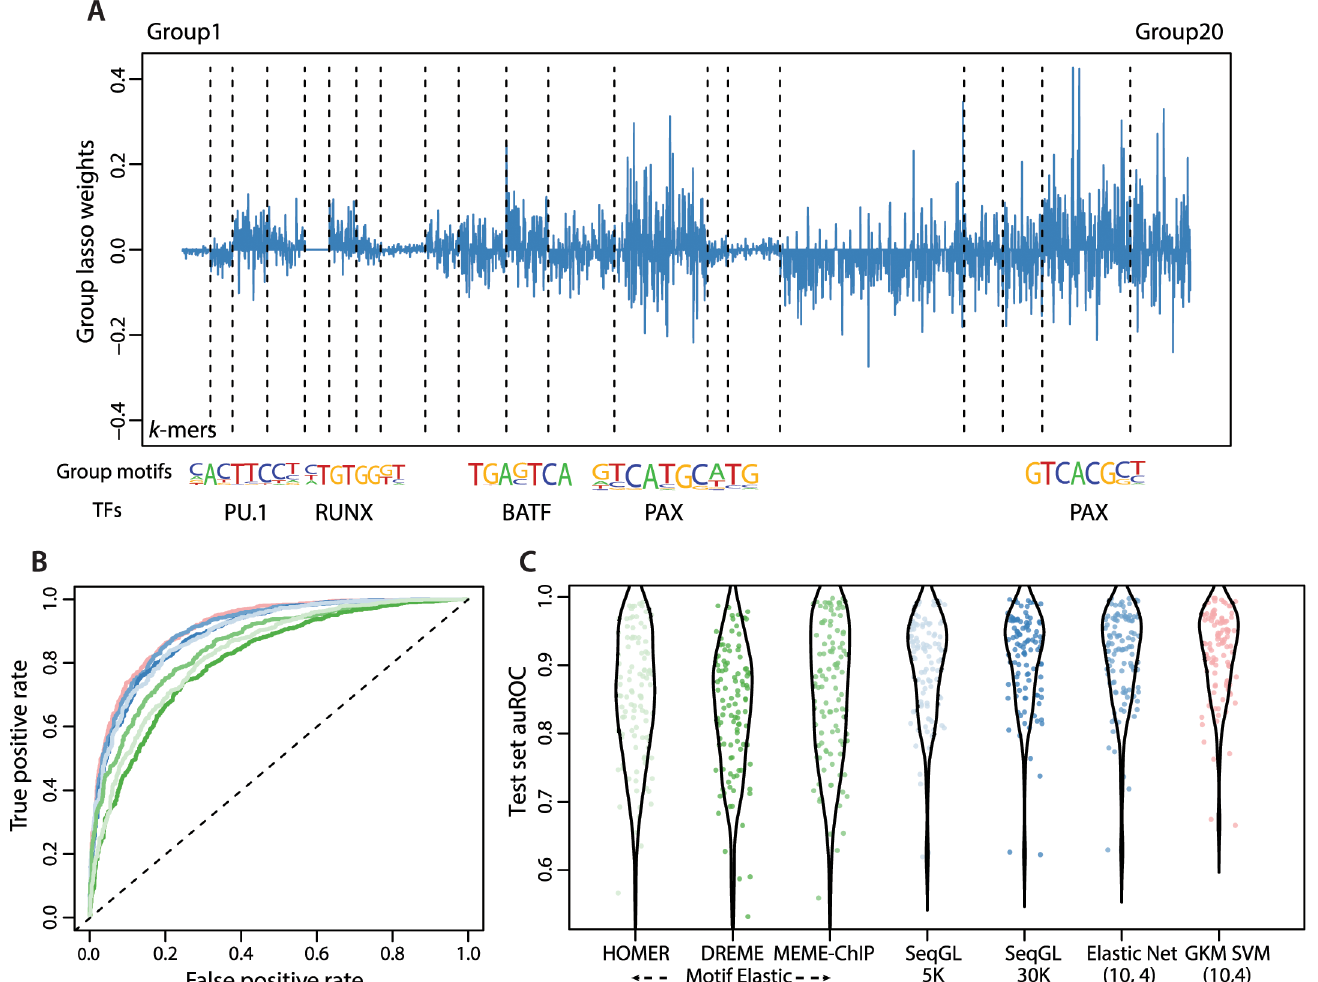
Fig 2. SeqGL performs significantly better than traditional motif discovery methods across different settings. (A) Plot showing the k -mer weight inferred group lasso regularized logistic regression for PAX5 ChIP-seq in GM12878 cell line. A number of groups are uniformly set to 0 (Group 5), while other groups are either significantly predictive of peaks or flanks (Group 3 and Group 2 respectively). Motifs identified for groups that are strongly predictive of peaks and the corresponding TFs are also shown. (B) PAX5 ChIP-seq auROC on the test set comparing the discriminative performance of SeqGL with motif finding tools and k -mer methods. The different colors correspond to the colors in Fig 2C. (C) Plots showing auROCs on test sets for 105 ChIP-seq experiments using different tools and settings. Three different settings were used for the motif finding tools HOMER, DREME and HOMER (see S1 Fig). ‘ Best motif ’ uses the highest-ranking motif from each method, as defined by the p -value; ‘ Max motif ’ uses the motif with maximum log odds score in each example; and ‘ Motif elastic ’ uses elastic net logistic regression across all motifs determined by the respective method. Only the ‘ Motif elastic ’ methods are shown in the performance plots, since they outperform the ‘ Best motif ” and ‘ Max motif ” methods. ‘ SeqGL and other k -mer methods significantly outperform the different motif finding tools across all settings (Wilcoxon rank sum p -values < 7e-3). gkm-SVM performs marginally (but not significantly) better compared to SeqGL with 5K top discriminative features (Wilcoxon rank sum p -value = 0.06); SeqGL using a larger feature set (30K) gives identical performance to gkm-SVM (no difference in the distribution of auROC scores based on a Wilcoxon rank sum test, using p -value < 0.05 for our threshold of significance). Furthermore, the elastic-net regressor on the full SeqGL feature space using 10-mers with 3 wildcards (similar to settings used by gkm-SVM) also yields identical performance. While the discriminative accuracy is comparable, unlike other k -mer methods, SeqGL identifies multiple distinct DNA binding signals from the same ChIP-seq experiment (S3